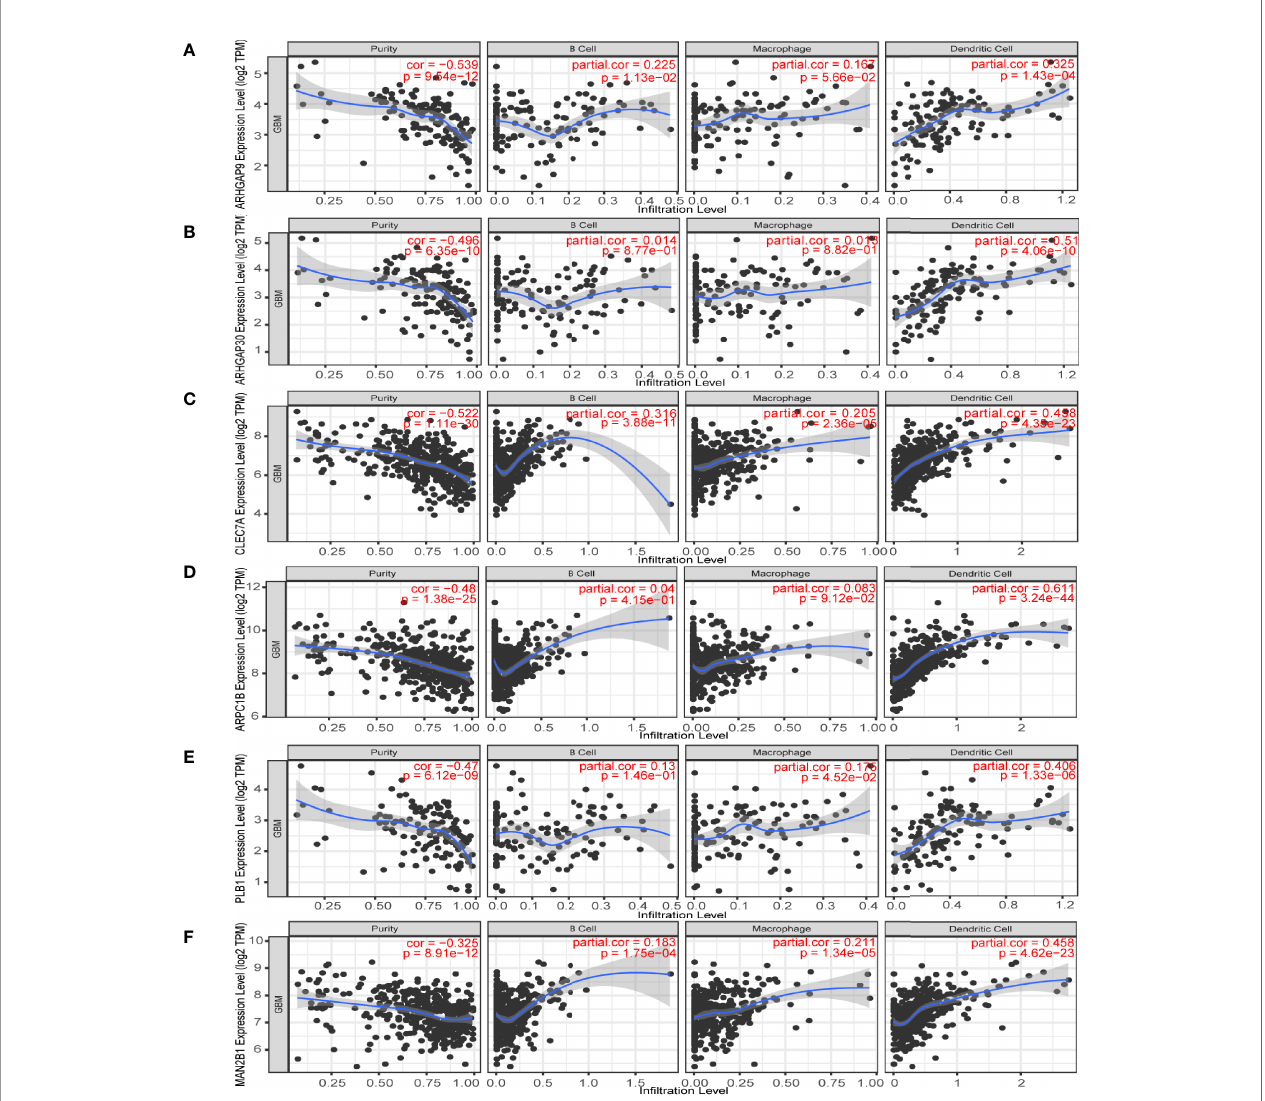
FIGURE 3 | Identi fi cation of tumor antigens associated with antigen-presenting cells (APCs). Correlation between the expression levels of (A) ARHGAP9, (B) ARHGAP30, (C) CLEC7A, (D) ARPC1B, (E) PLB1 and (F) MAN2B1 and in fi ltration of APCs (macrophages, dendritic cells, and B cells) in